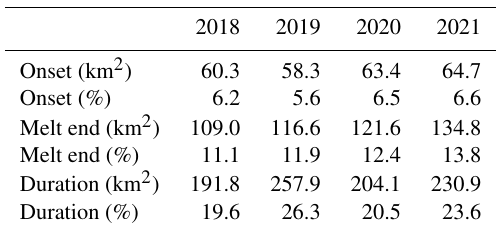
Table 3. Total corrected area for SAR estimates of melt onset, opti- cal estimates of snow disappearance, and optical-radar estimates of melt duration.